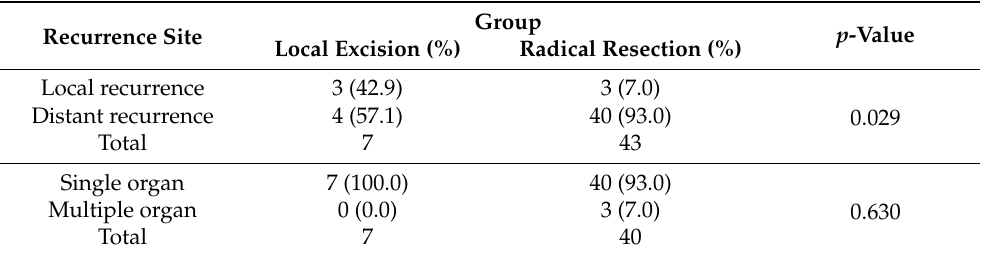
Table 2. Recurrence site in ypT0-1 rectal cancer treated with preoperative chemoradiotherapy according to the surgical method.